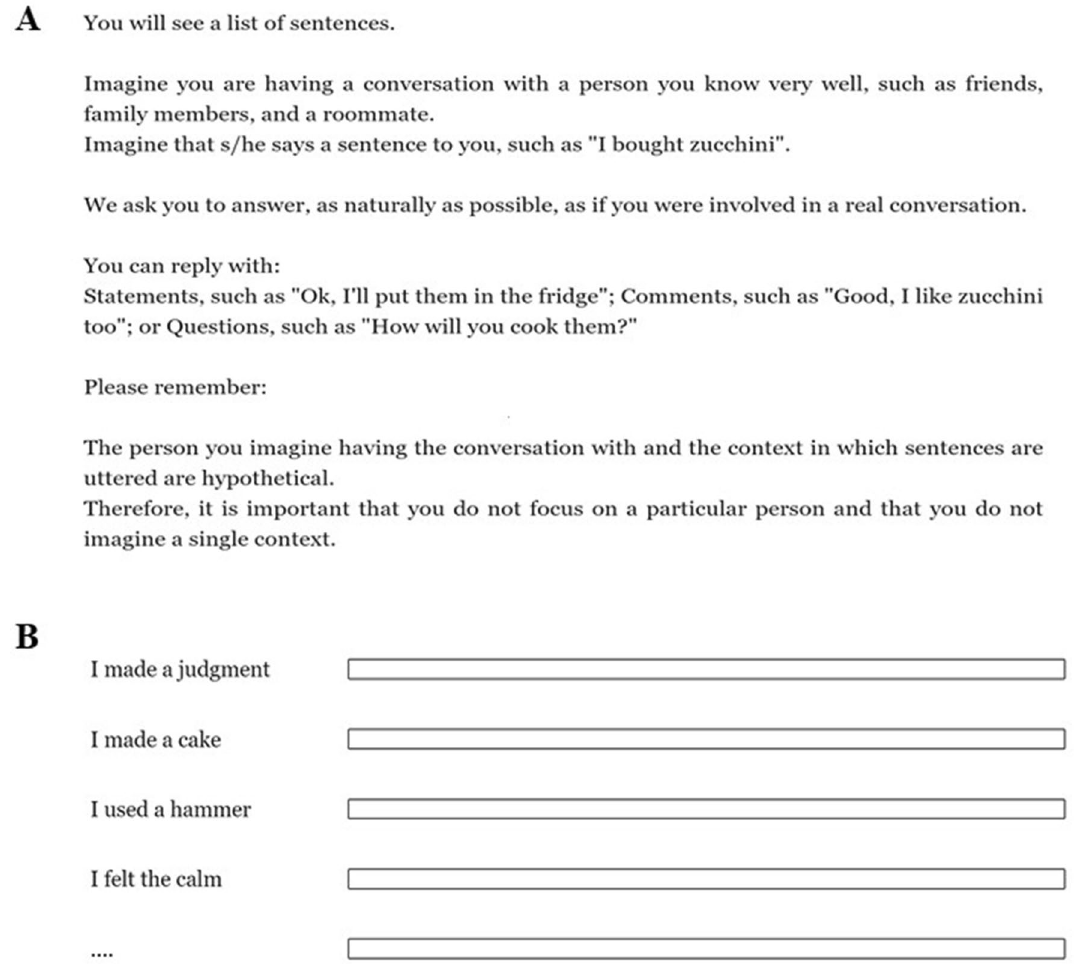
Figure 4. Instructions provided to the participants ( A ) and the Qualtrics interface with examples of four sentences used in the study ( B